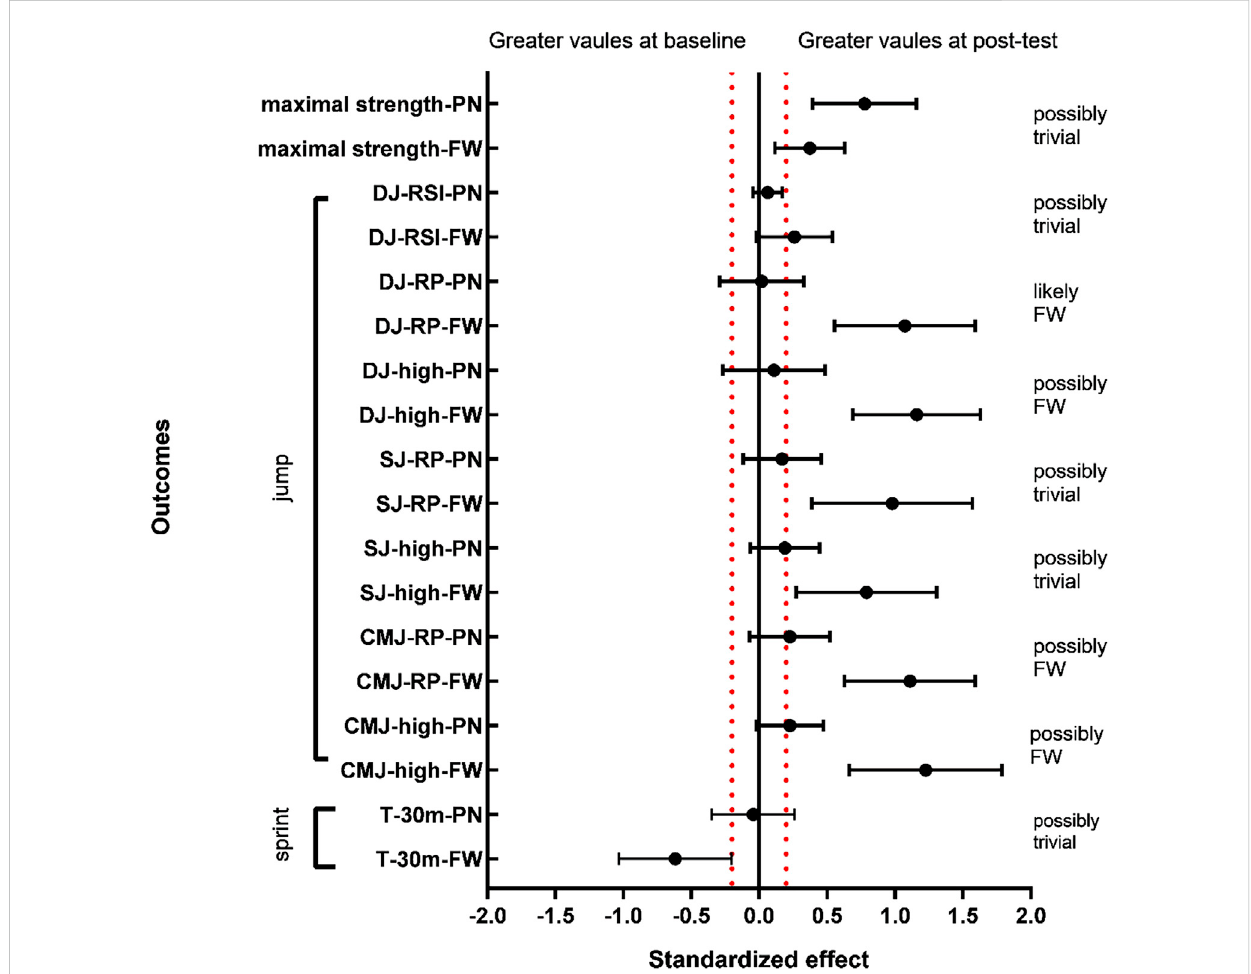
FIGURE 5 Normalizedresults(90%con fi denceinterval)foralloutcomesatthebaselineandpost-trainingfortheFWandPNgroups.T-30=30-mshortstroke time;CMJ-high=reverseverticaljumpheight;CMJ-RP=relativepowerofreverseverticaljump;SJ-high=isometricsquatjumpheight;SJ-RP=relative power of isometric squat jump; DJ-high = drop jump height; DJ-RP = relative power of drop jump; and DJ-RSI = reaction power index of drop